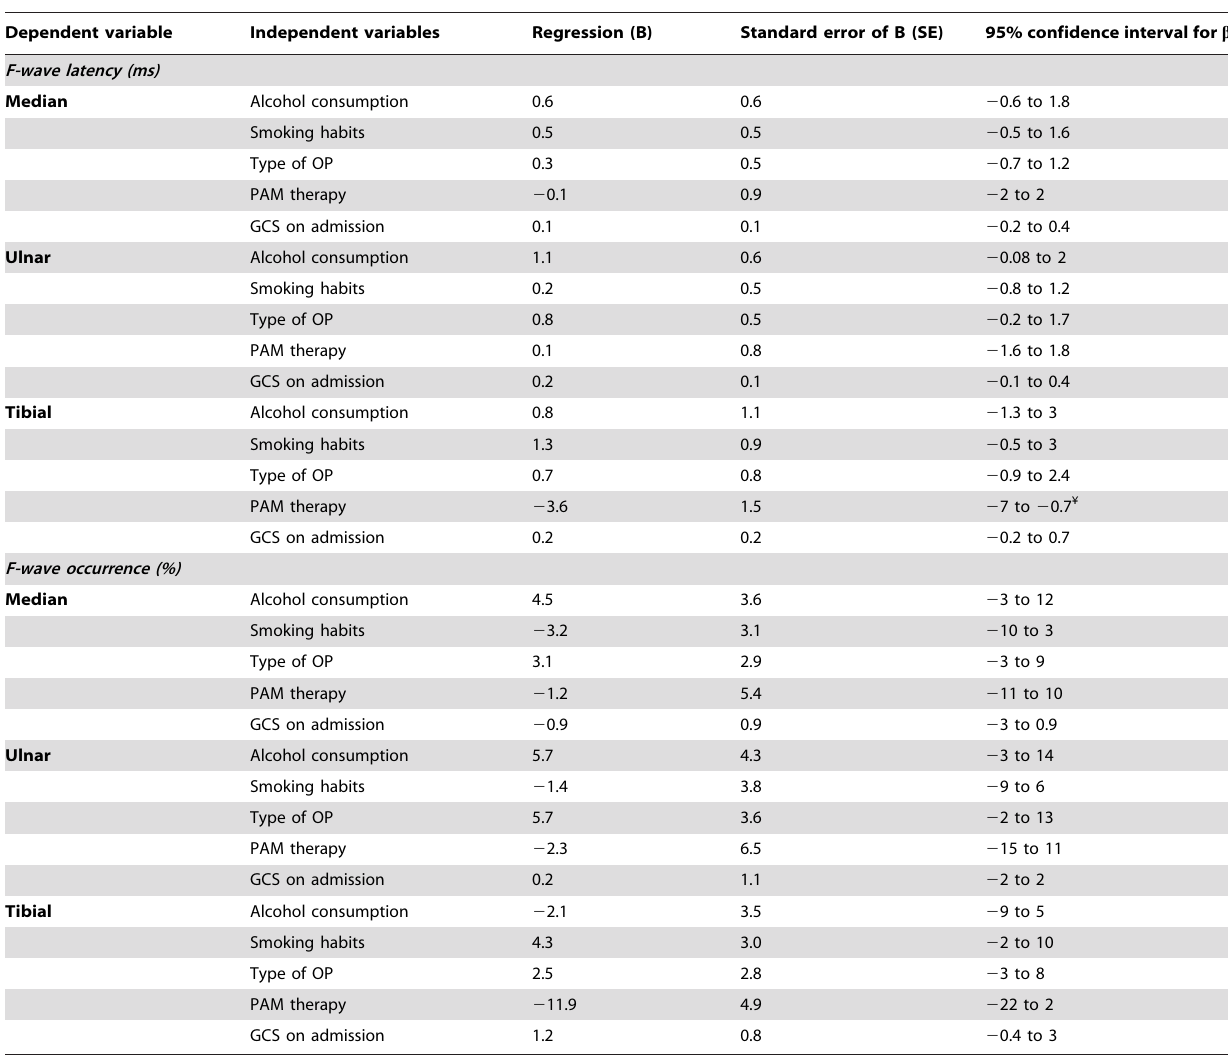
Table 7. F wave studies - multiple linear regression for confounders.